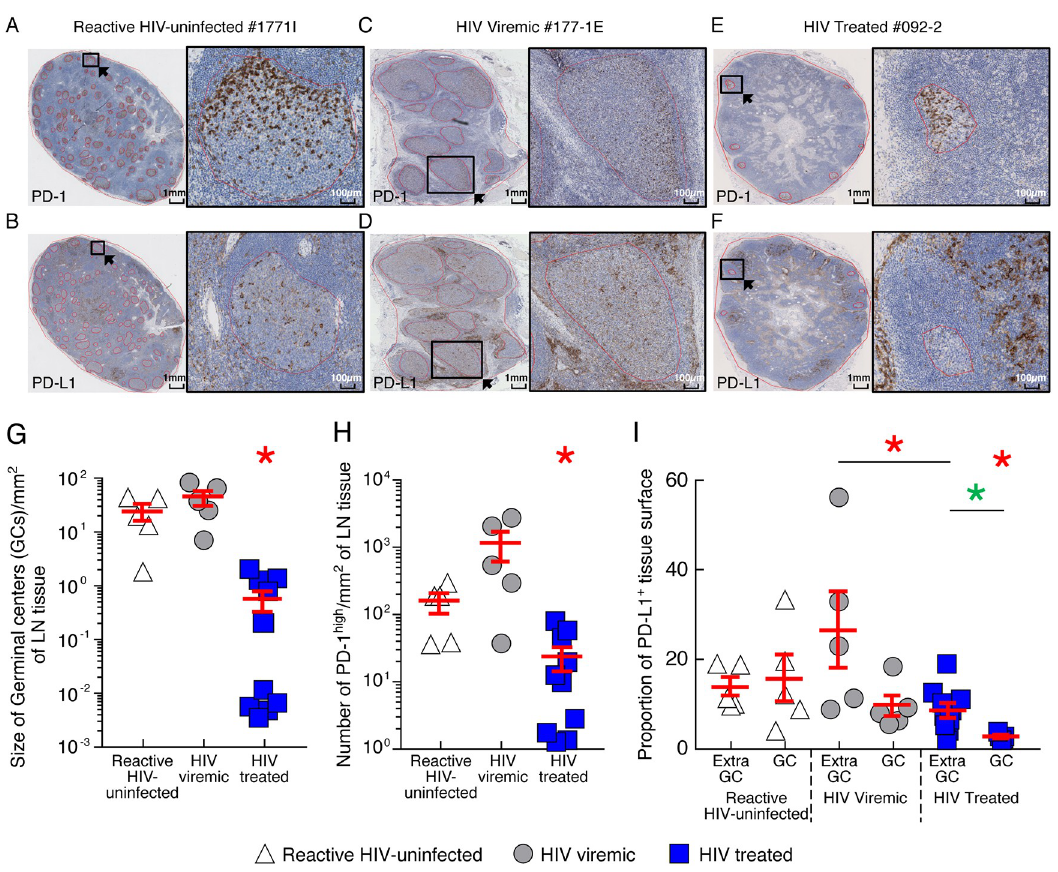
Fig 3. PD-1 and PD-L1 expression and tissue distribution in LN tissues. Representative examples of PD-1 ( A, C and E ) or PD-L1 ( B, D and F ) immunohistochemistry staining of LNs of reactive HIV-uninfected (#177-1I, A-B ), viremic (#177-1E, C-D ) and aviremic ART treated HIV-infected individual (#092–2, E-F ). (G) Size of GCs per mm 2 of LN tissue of reactive HIV-uninfected (N = 5), viremic (N = 5) and aviremic ART treated HIV-infected individual (N = 10). (H) Number of PD-1 high cells per mm 2 of LN tissue of reactive HIV-uninfected (N = 5), viremic (N = 5) and aviremic ART treated HIV-infected individual (N = 10). (I) Proportion of PD-L1 + tissue surface of reactive HIV-uninfected (N = 5), viremic (N = 5) and aviremic ART treated HIV-infected individual (N = 10). Red circles represent GCs ( A-F ). Black squares correspond to the magnified areas ( A-F ). PD-1 expressing cells and PD-L1-positive areas were quantified using defined algorithms within total LN tissue area and within each GCs. White triangles correspond to reactive HIV-uninfected subjects, grey circles correspond to HIV-infected viremic individuals and blue squares correspond to aviremic ART treated HIV-infected individuals (G-I) . Red bars correspond to mean ± SEM (G-I) . Red stars indicate statistical significance ( P < 0.05) for inter-group comparisons and green stars indicate statistical significance ( P < 0.05) for inter- region comparisons. Statistical significance ( P values) was obtained using one-way ANOVA (Kruskal-Wallis test) followed by Wilcoxon Matched-pairs two-tailed Signed Rank test (inter-group comparisons) or by Mann Whitney test (inter-region comparisons).